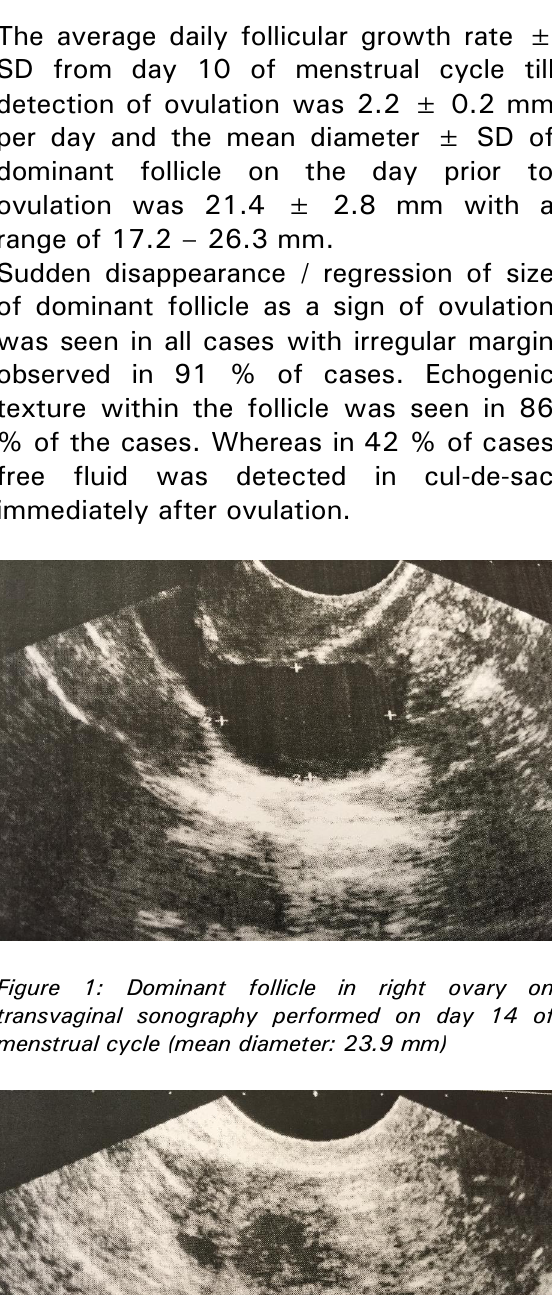
Table 3: Mean diameter of Dominant follicle Day of Menstrua